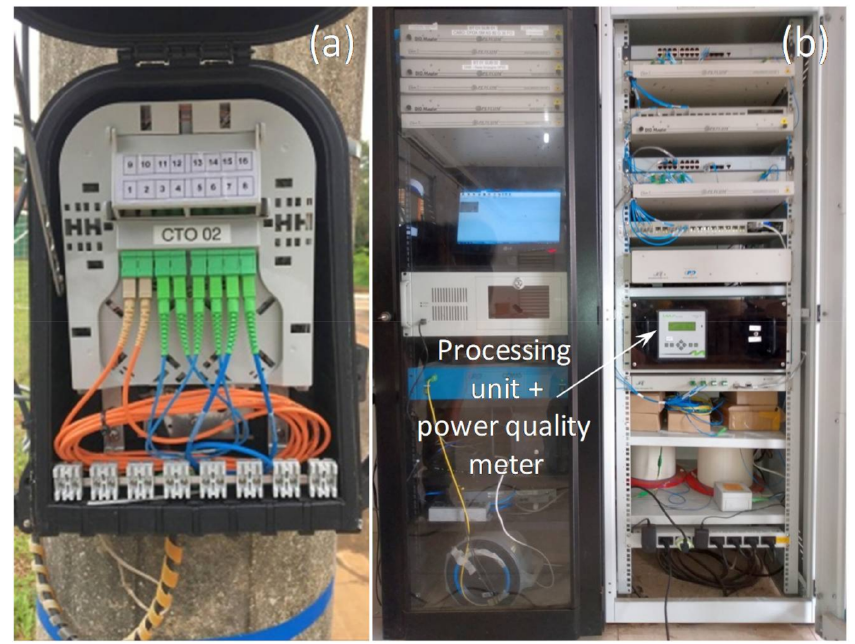
Figure A4. ( a ) The connections of the sensors fibers to the SN fibers done in an OTB and ( b ) processing unit and the power quality meter installed in the 19” rack in the control